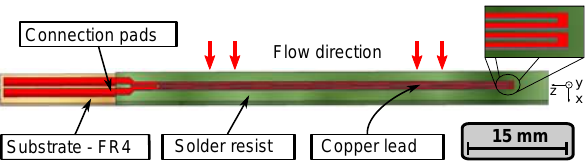
Figure 1. Hot-film anemometer produced on a PCB with a 100µm thick substrate (beige). The thickness of the copper leads (red) and of the solder resist (green – covers the copper leads except the con- nection pads) amounts to 5 and 40µm,